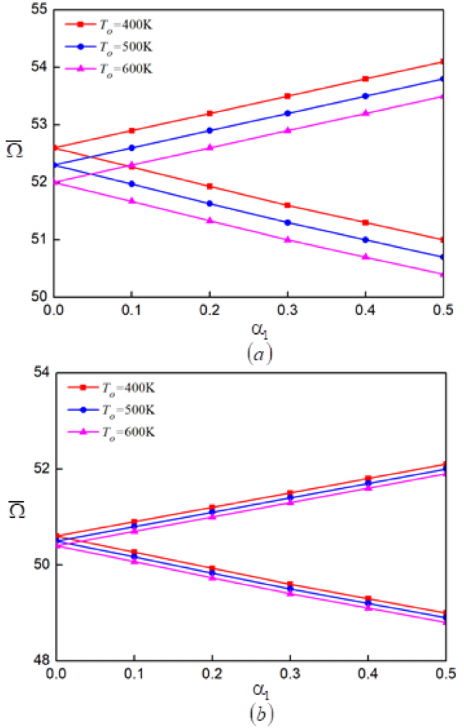
Figure 10. The dynamic unstable regions of the CFRP laminated cylindrical shell with different temperature fields: ( a ) first mode, and ( b ) second